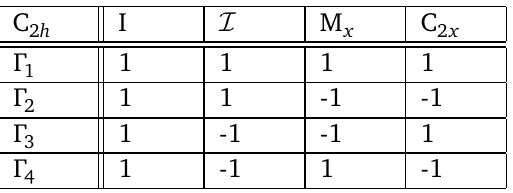
Table 1: Character Table of C of the group.